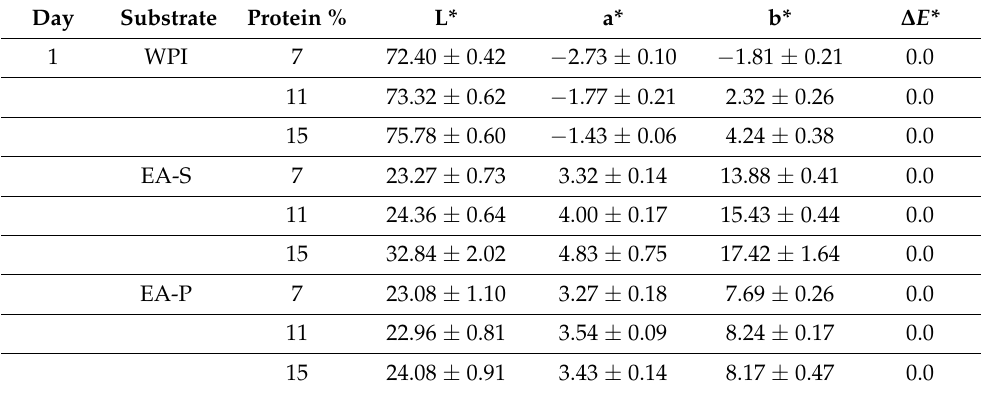
Table 3. Color evolution during storage on gels made by using gelatin and different isolated